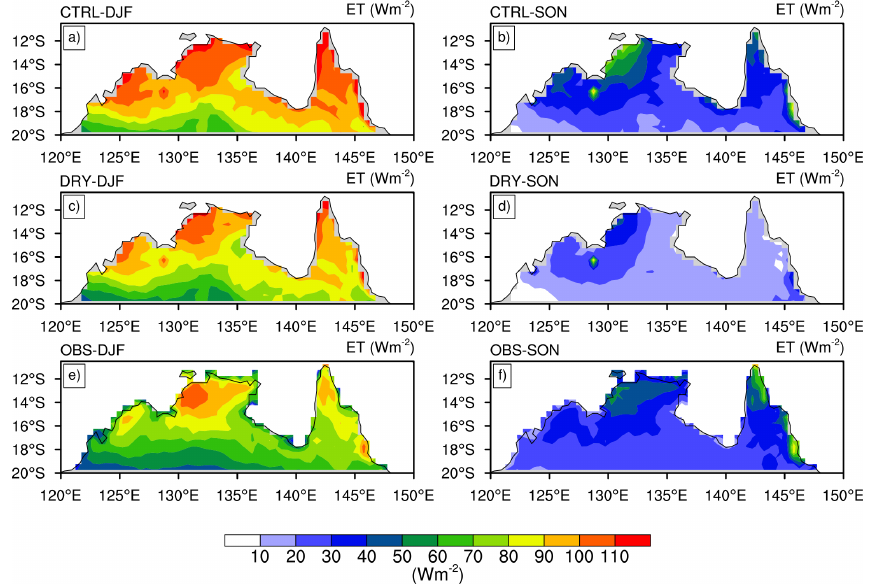
Figure 3. The mean ET (Wm − 2 ) from the wet season (DJF shown in the left hand column) and the transition between the dry and wet seasons (SON shown in the right hand column). The ensemble mean ET from (a) CTRL over DJF, (b) CTRL over SON, (c) DRY for DJF, (d) DRY from SON, (e) OBS (the mean of three gridded ET products) over DJF, and (f) OBS for SON.